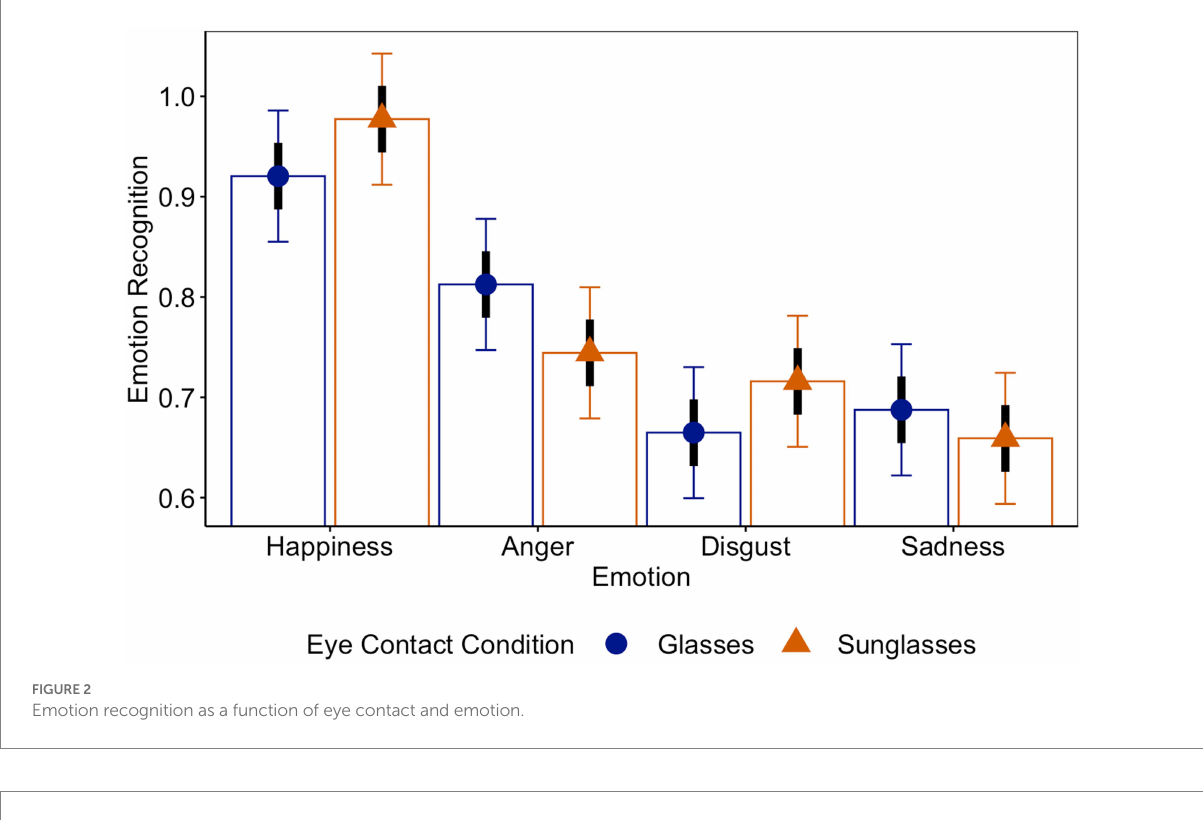
FIGURE 2 Emotion recognition as a function of eye contact and